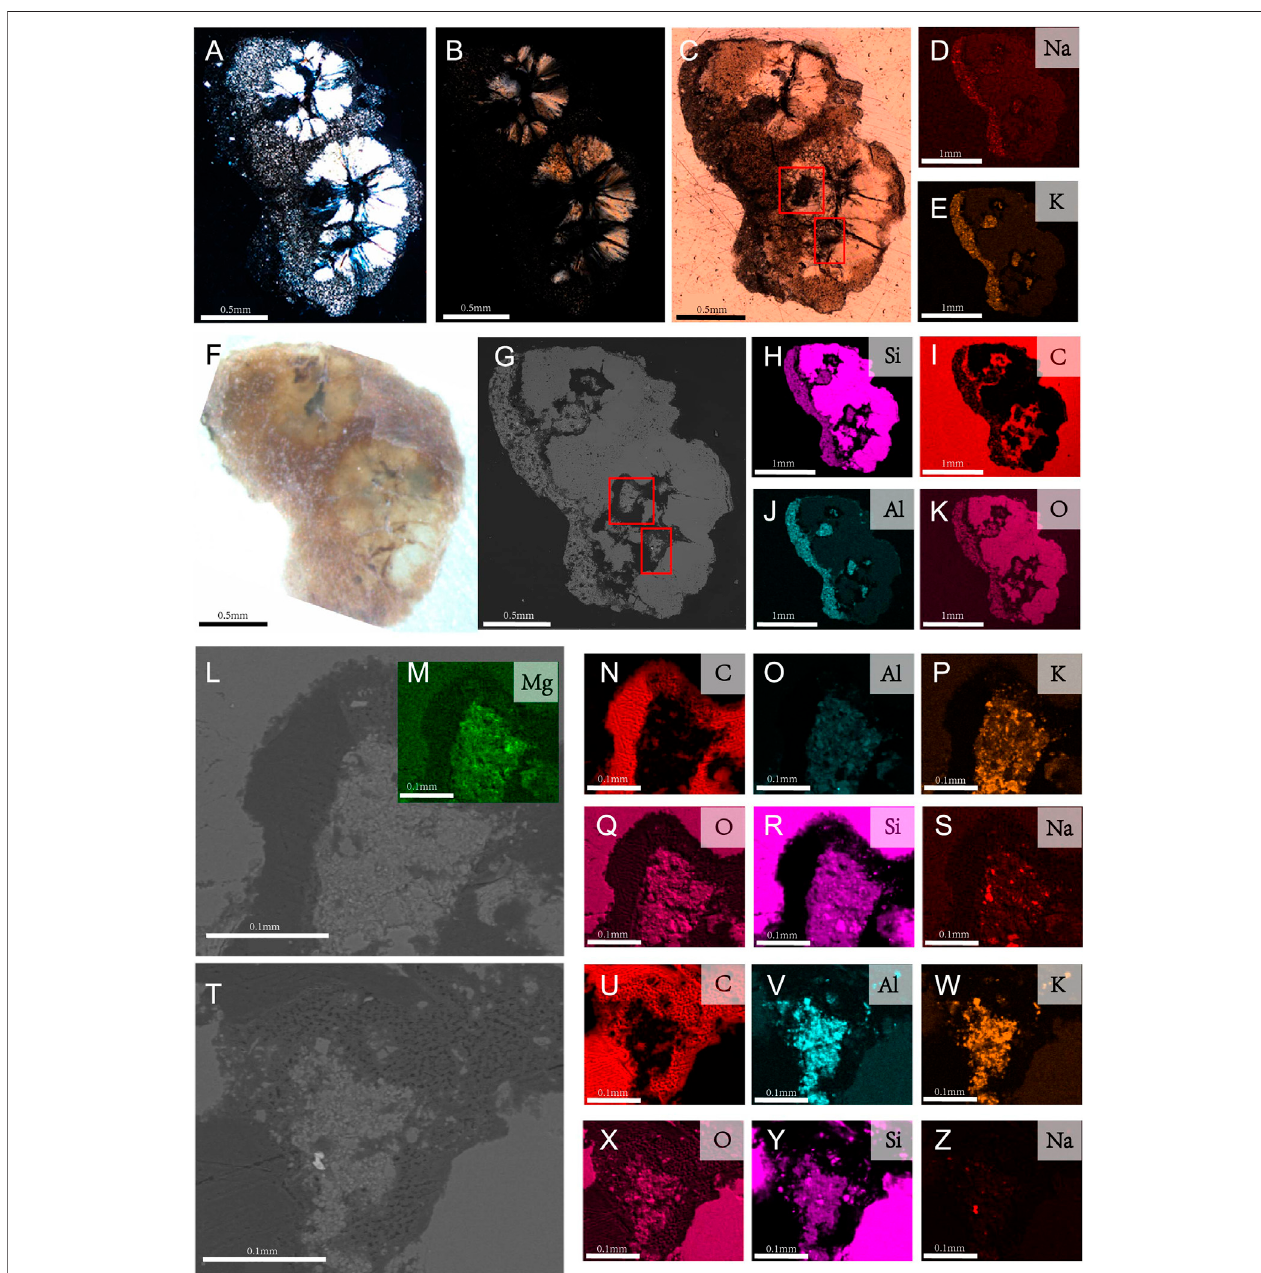
FIGURE 3 | Lithology results and EDS element mapping of the ground-sections of the purported gastroliths of Bohaiornis guoi IVPP V17963. (A,B) . Photographs underpolarizedlightthroughmicroscope; (A) .Inhighbrightness; (B) .Inlowbrightness; (C) .Photographundernaturallight; (D,E,H – K) .Elementalmappingresultsofthe wholeslide.Itsmajorelementsincludesodium(Na),potassium(K),silicon(Si),carbon(C),aluminum(Al),oxygen(O); (F) .PhotographunderStereoMicroscope; (G) .SEM photograph. (I – Z) . Close up photographs of intermediate region of purported gastroliths; Close up regions (L,T) are the regions boxed in (C,G) . (M – S) . Elements mapping of (L) ; (U – Z) . Elements mapping of (T)